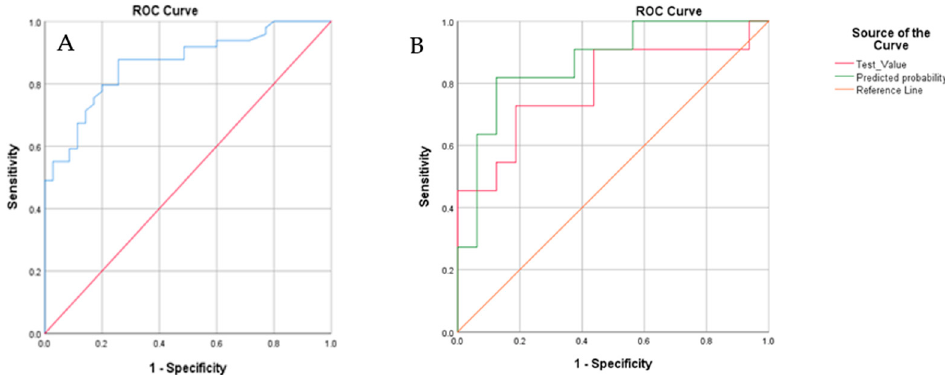
Figure 5. ( A ) The ROC curve for the blind set. The diagonal red line represents the line of no-discrimination, while the blue curve represents different sensitivities and specificities with altered thresholds. The area under the curve is 0.882; ( B ). ROC curves showing the best fit of data for cross-validation when including in the statistical analysis; the clinical parameters of gender, age, smoking (total pack-year), and toombak use (green line; the area under the green curve is 0.92) are compared to the best fit for cross-validation when only the e-nose test values are analyzed (red line).